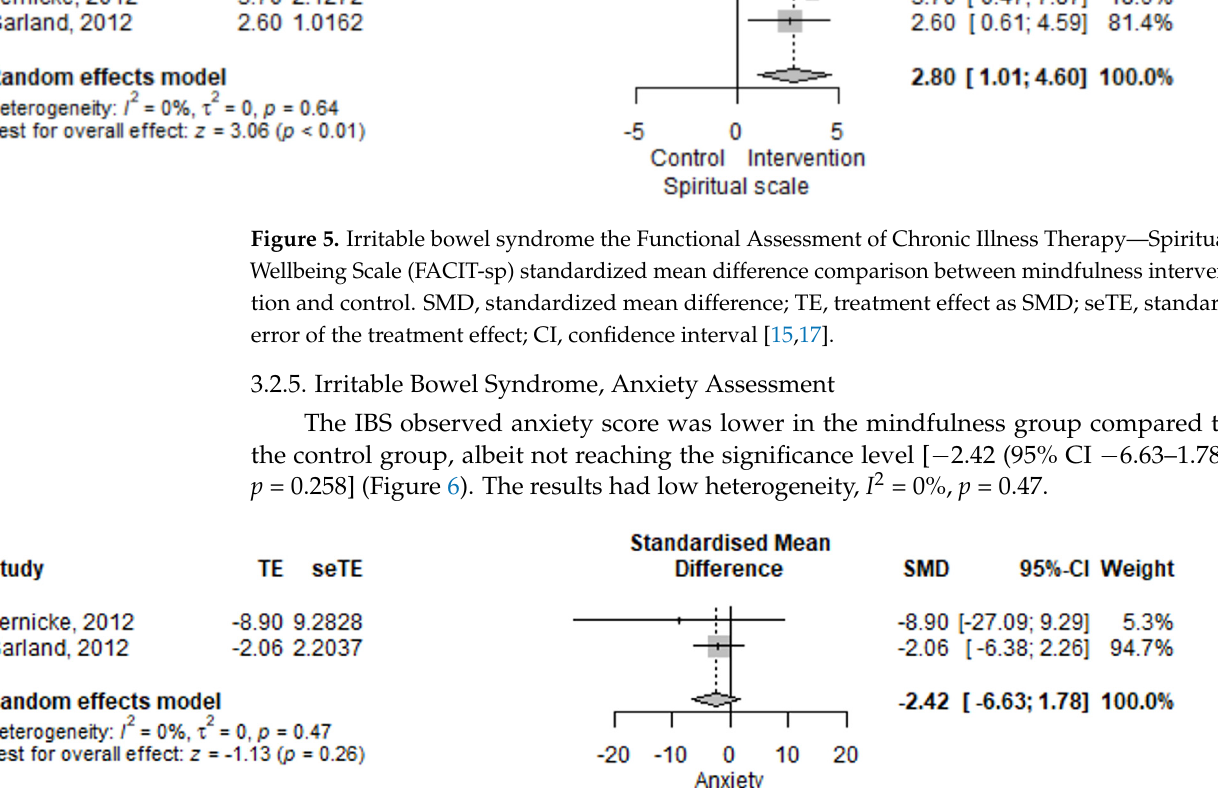
Figure 6. Irritable bowel syndrome anxiety scale—standardized mean difference comparison between